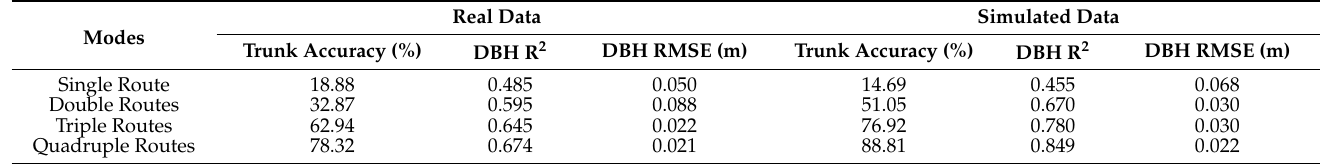
Figure 11. Accuracy variation curves of ( a ) trunk point extraction and ( b ) DBH measurement with different routes. Table 6. Extraction accuracies of trunk points and DBH from the real and simulated data in different modes.